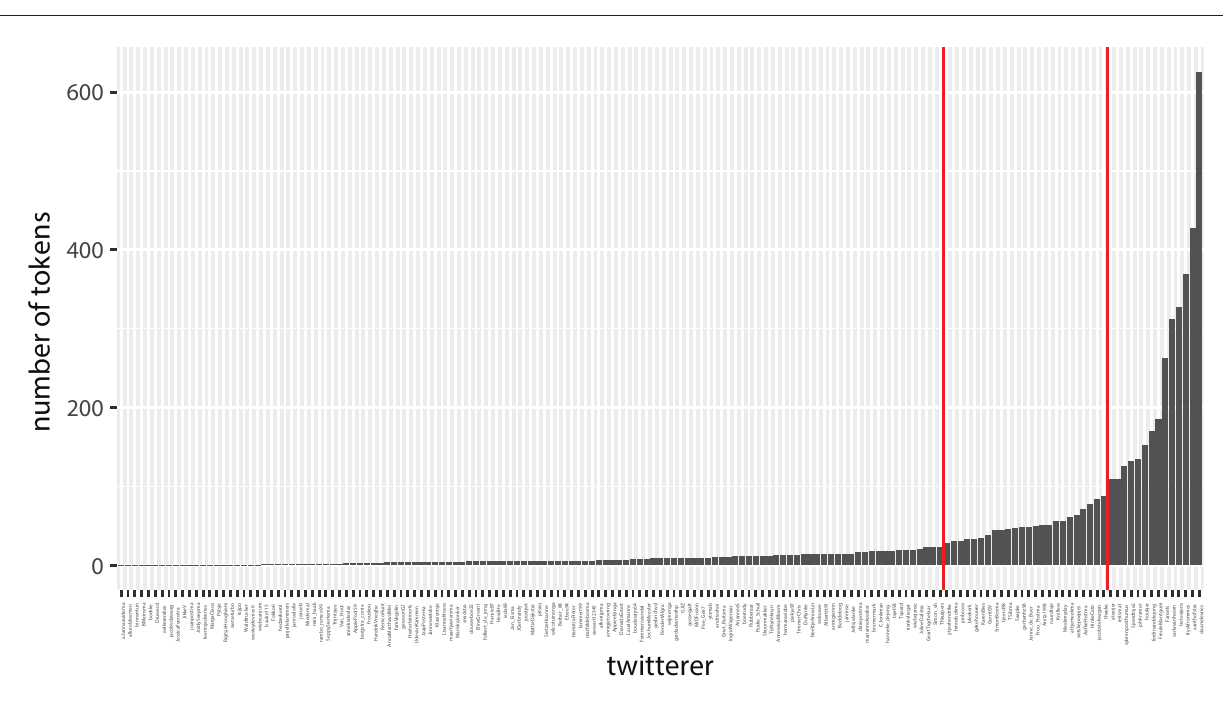
FIGURE 6 | Number of tokens per Twitterer ( N =